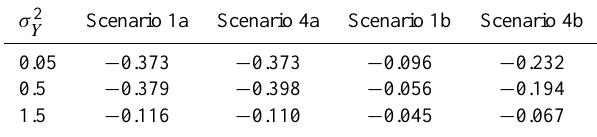
Table 2. Inversion performance for scenarios 1a, 4a, 1b, and 4b (in terms of Y RMSE relative changes between prior and estimated so- lutions) as a function of the reference field Y